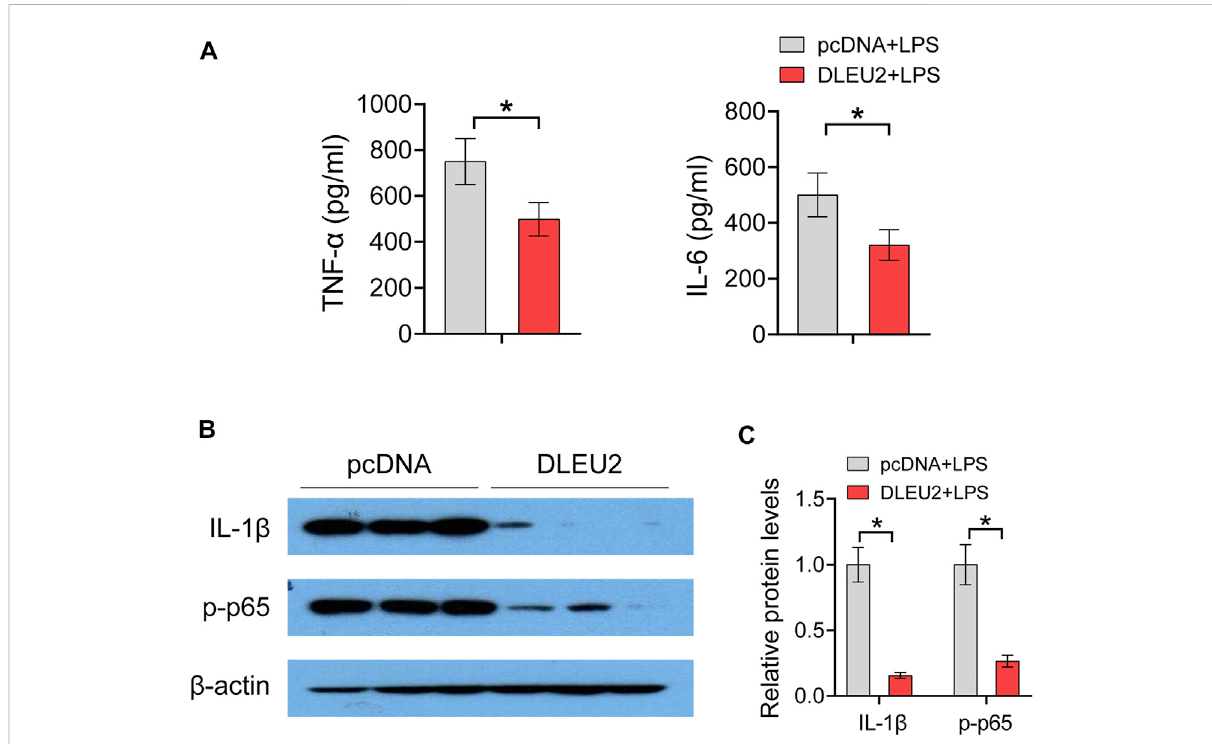
FIGURE 4 DLEU2 inhibits NF- κ B signaling pathway. (A) The level of IL-6 and TNF- α protein in THP-1 cells transfected with DLEU2 or pcDNA. (B) The protein expression level of IL-1 β and p-p65 in THP-1 cells transfected with DLEU2 or pcDNA. (C) Quanti fi cation data of (B) . n = 3 per group. p < 0.05 ( t